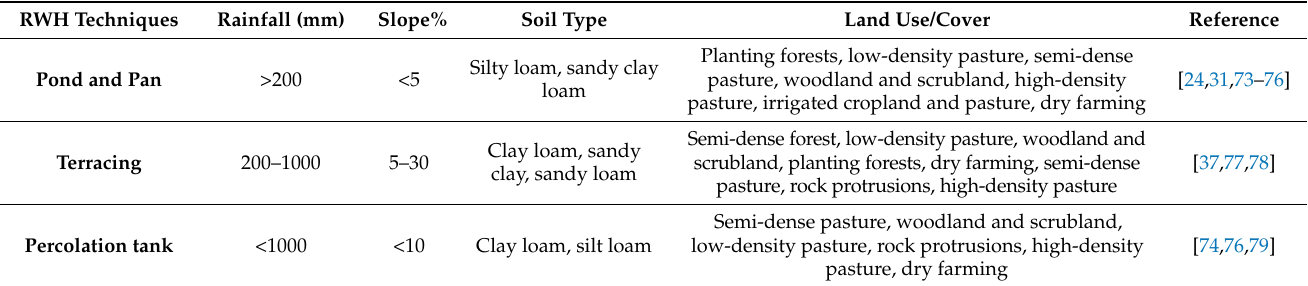
Table 2. The common techniques and criteria used for RWH site selection in ASARs. RWH